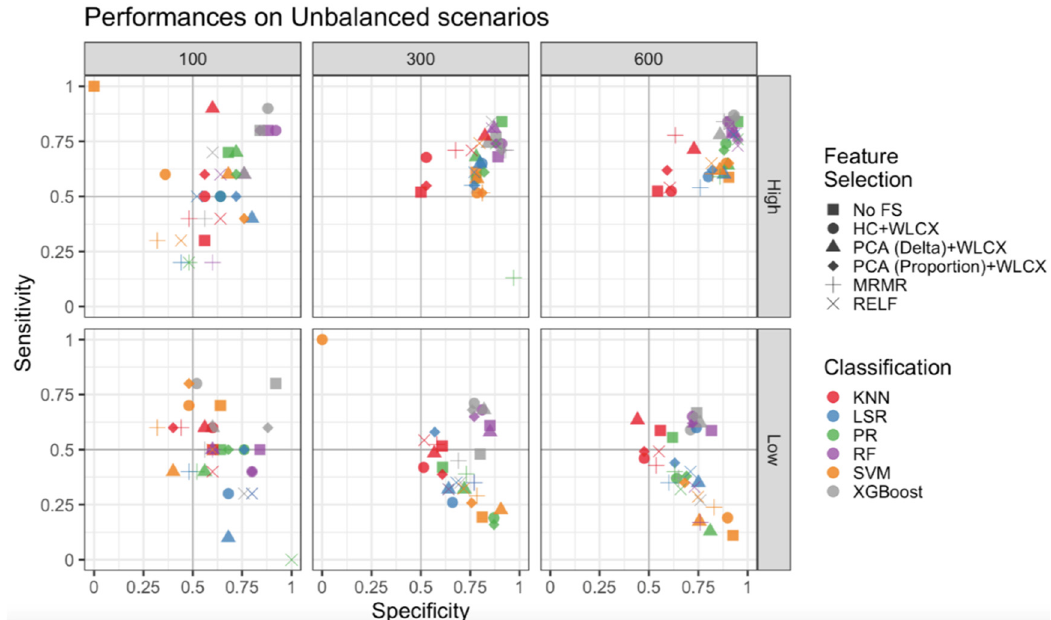
Figure 3. Sensitivity and Specificity for unbalanced datasets. Performances of the classification and feature selection methods applied to the unbalanced cases are displayed for a high signal (upper panels) and a low signal (lower panels). Columns report results for the different sample sizes. Colors are used to distinguish classification algorithms, shapes for feature selection methods.